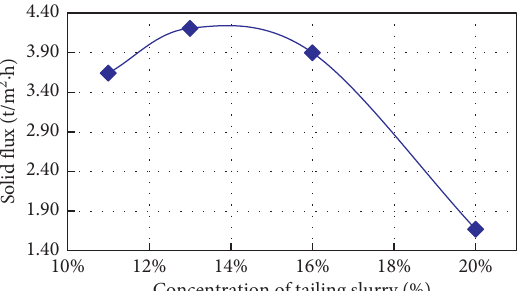
Figure 2: Settlement curves with different tailing slurry